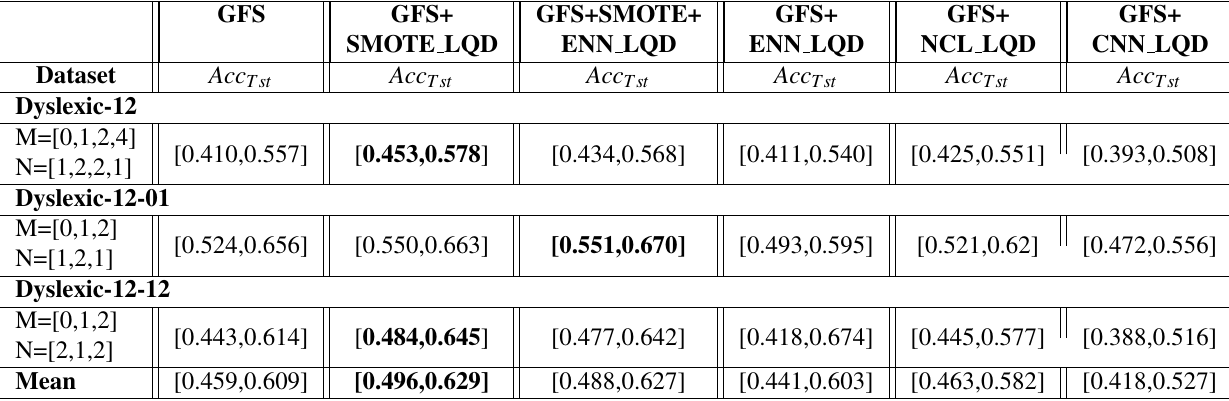
Table 6: Means of 100 repetitions of the GFS from low quality datasets of Dyslexic with 4 labels/variable with the original dataset and preprocessed with several preprocessing